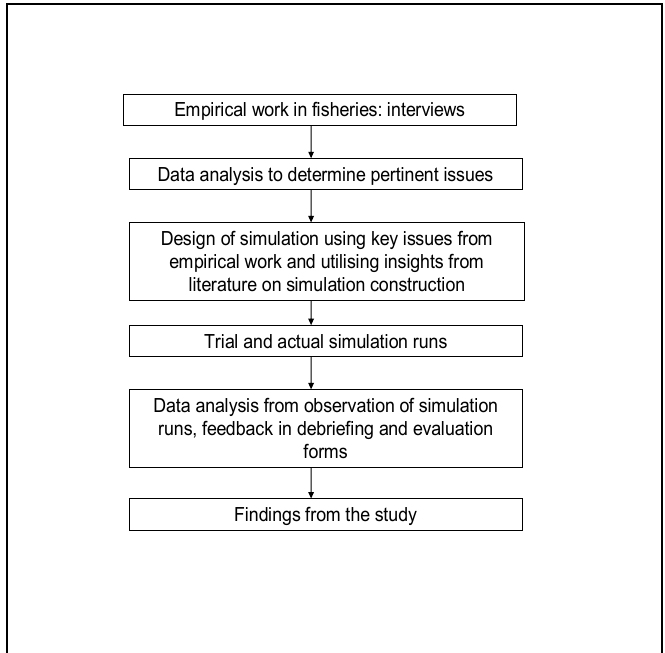
Figure 1: Flow diagram of approach undertaken